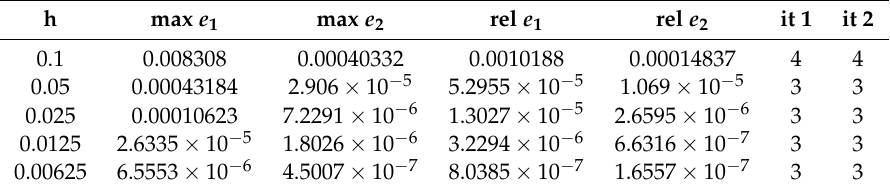
Table 1. Multisplitting classic version.